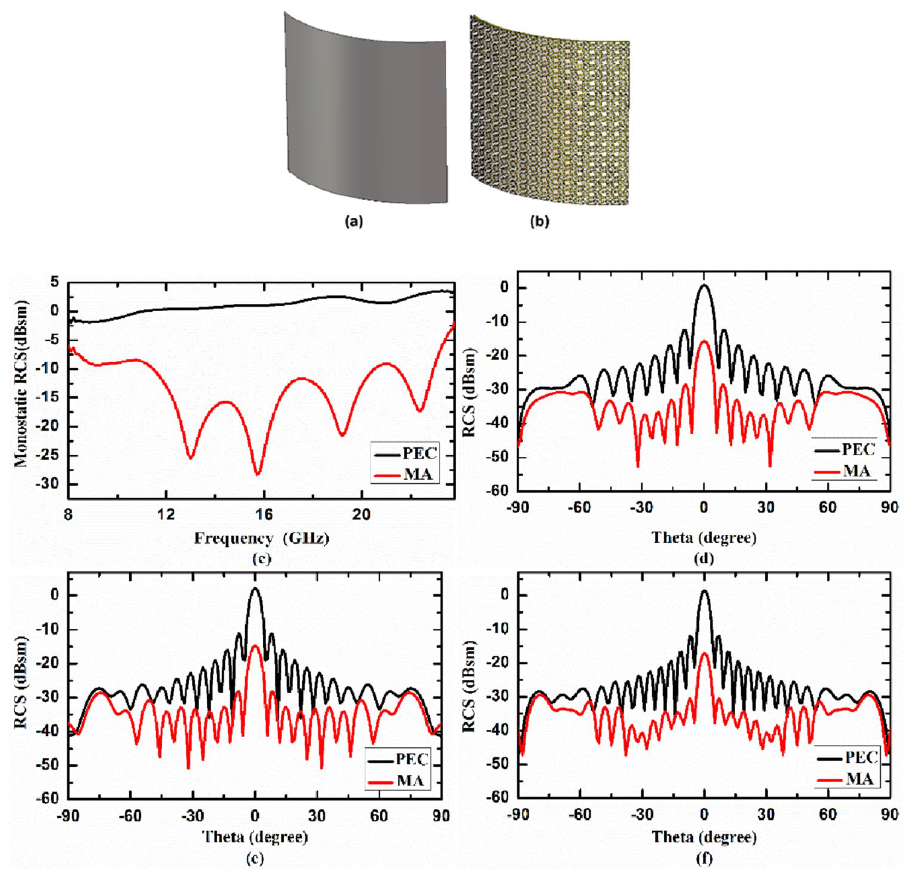
Figure 7. 3D view of cylindrically bent ( a ) PEC and ( b ) MA with radius of curvature 130 mm, ( c ) monostatic RCS, and bistatic RCS at ( d ) 14.84 GHz, ( e ) 17.99 GHz, ( f ) 21.14 GHz under normal